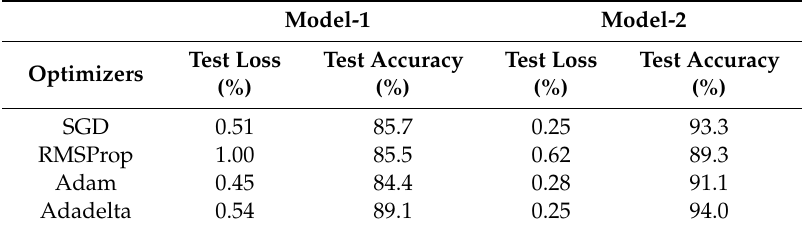
Table 4. Comparison of the optimizers for tissue image